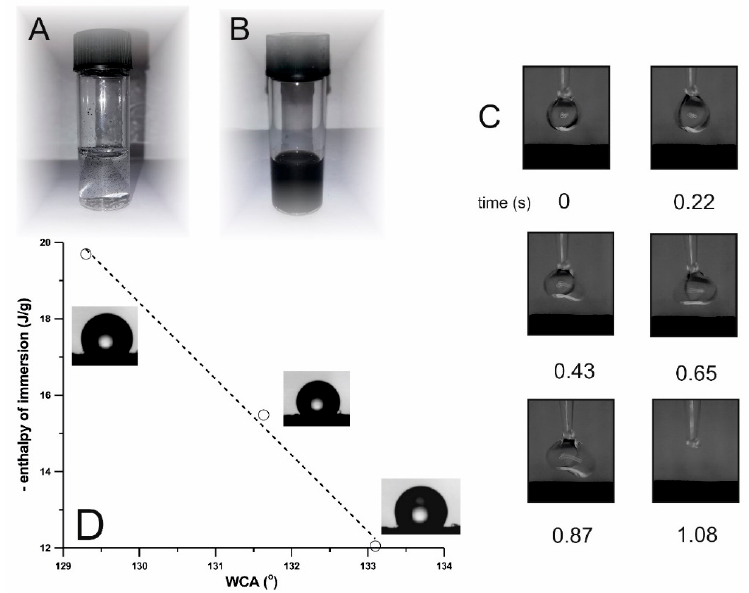
Figure 10. Aqueous dispersions of in-house MWCNT array tiny flakes: pristine ( A ) and covalently modified by Ullmann-type reaction of chlorinated arrays with 1,3,5-trihydroxybenzene – identical weight and no ultrasonication applied ( B ); wetting dynamics of 1,3,5-trihydroxybenzene (THB) covalently modified in-house ‘MWCNT carpet’ – snapshots of photographs in the timescale of seconds for a drop released from a goniometer ( C ); the correlation between wetting contact angle (WCA) and the enthalpy of immersion for three samples: pristine, blank experiment (no catalyst in the Ullmann reaction) and non-covalently treated with 1,3,5-trihydroxybenzene in-house vertically aligned MWCNT array ( D ).